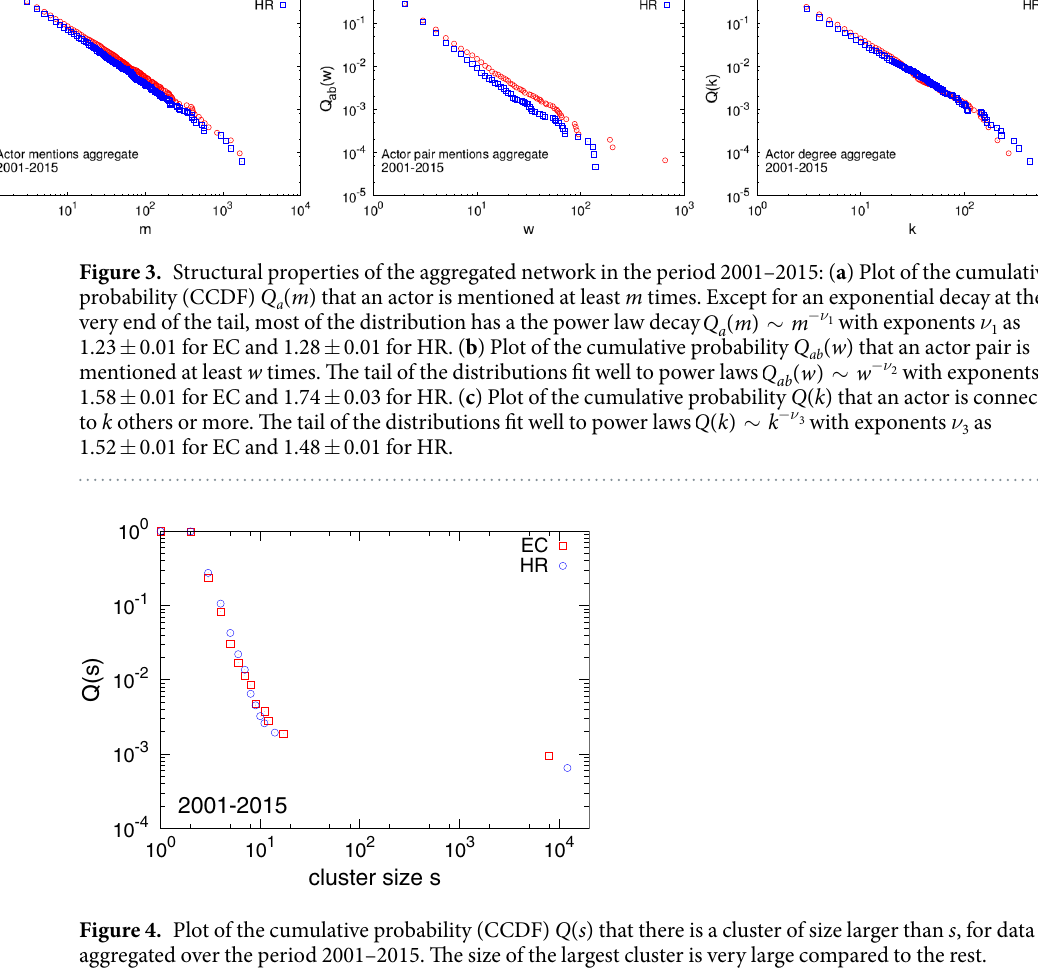
Figure 4. Plot of the cumulative probability (CCDF) Q ( s ) that there is a cluster of size larger than s , for data aggregated over the period 2001–2015. The size of the largest cluster is very large compared to the